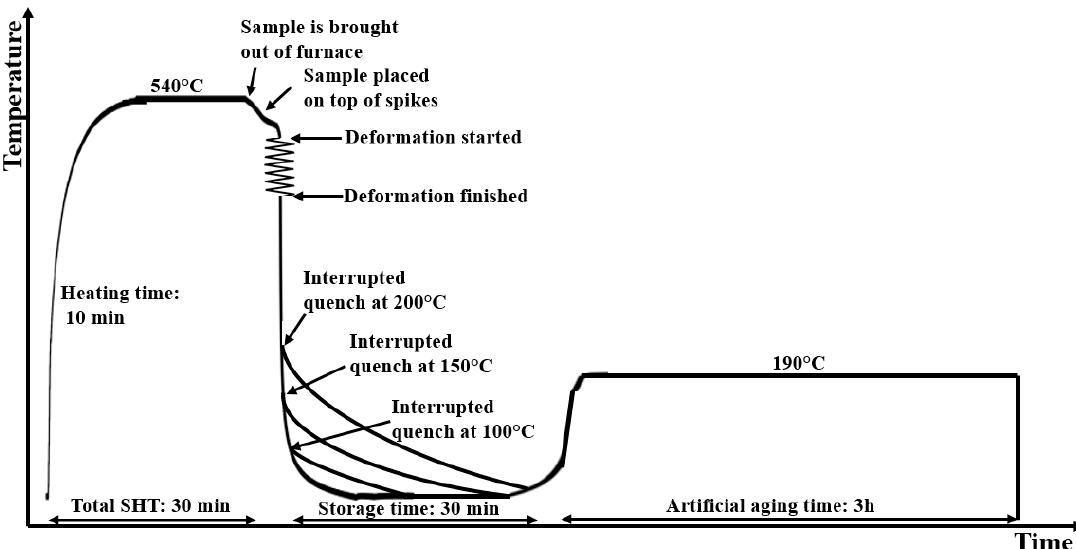
Figure 3. Illustration of the integrated HFQ heat treatment sequence for samples being stored at room temperature before artificial aging.